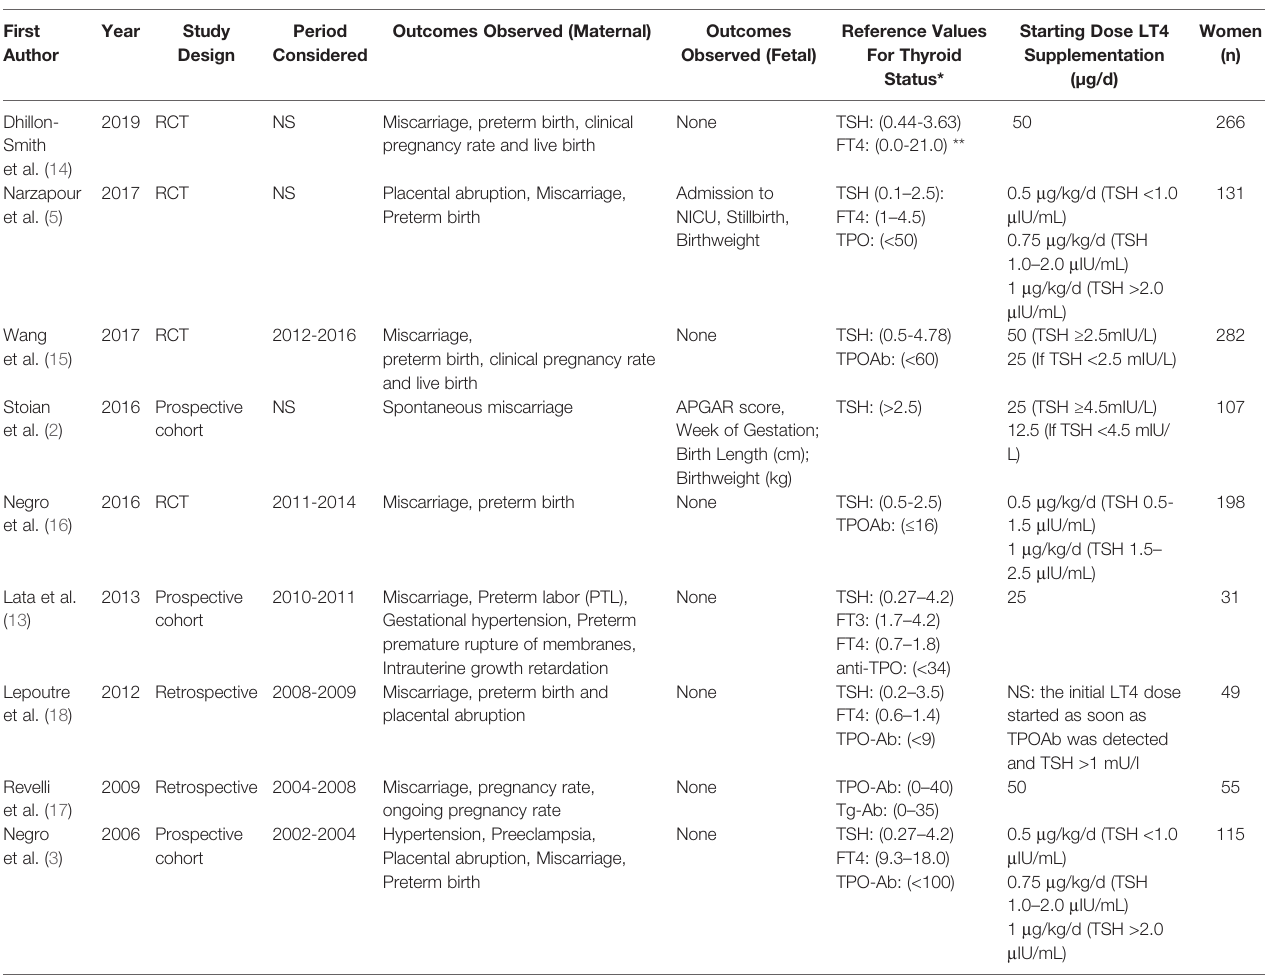
TABLE 1 | General characteristics of the included